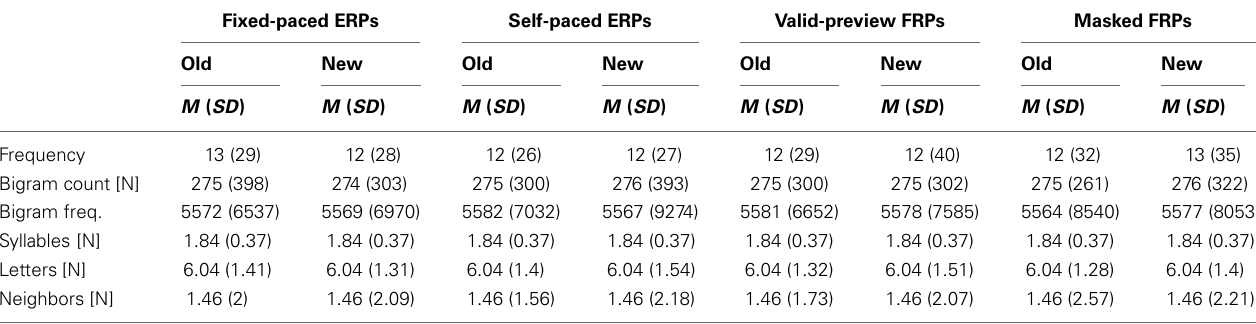
Table A2 | Means (standard deviations) of the characteristics of the pretarget words of the four experimental